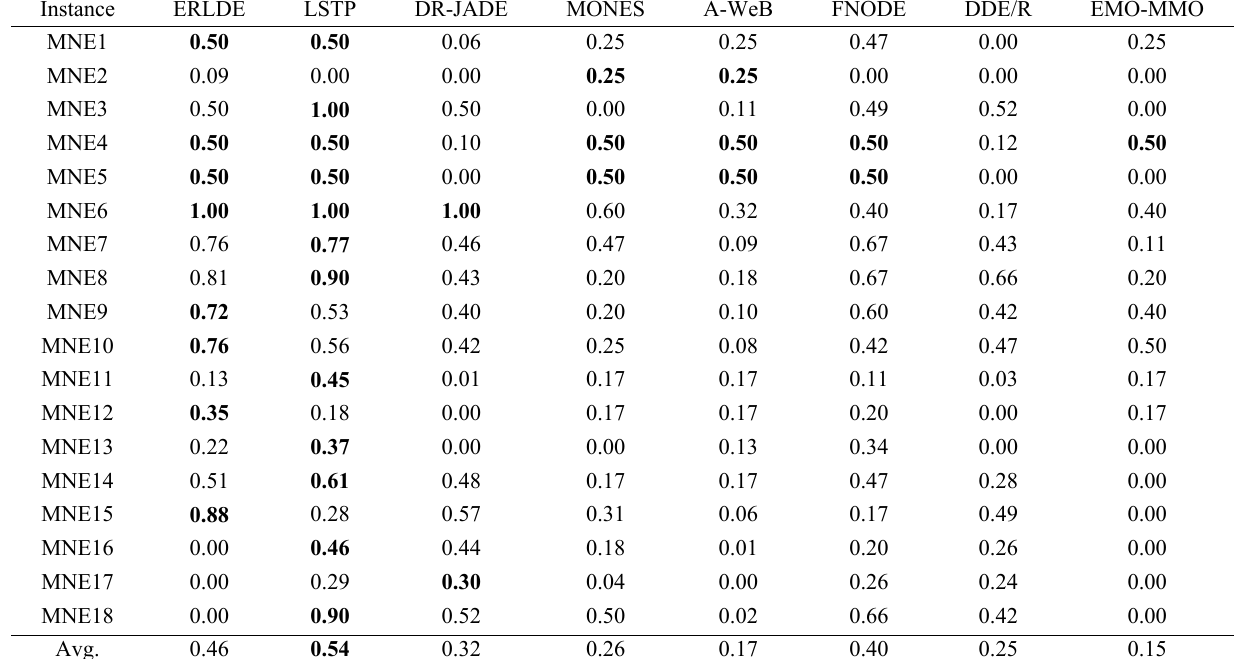
Table A7 Comparison of different algorithms on the new test set in terms of RR .